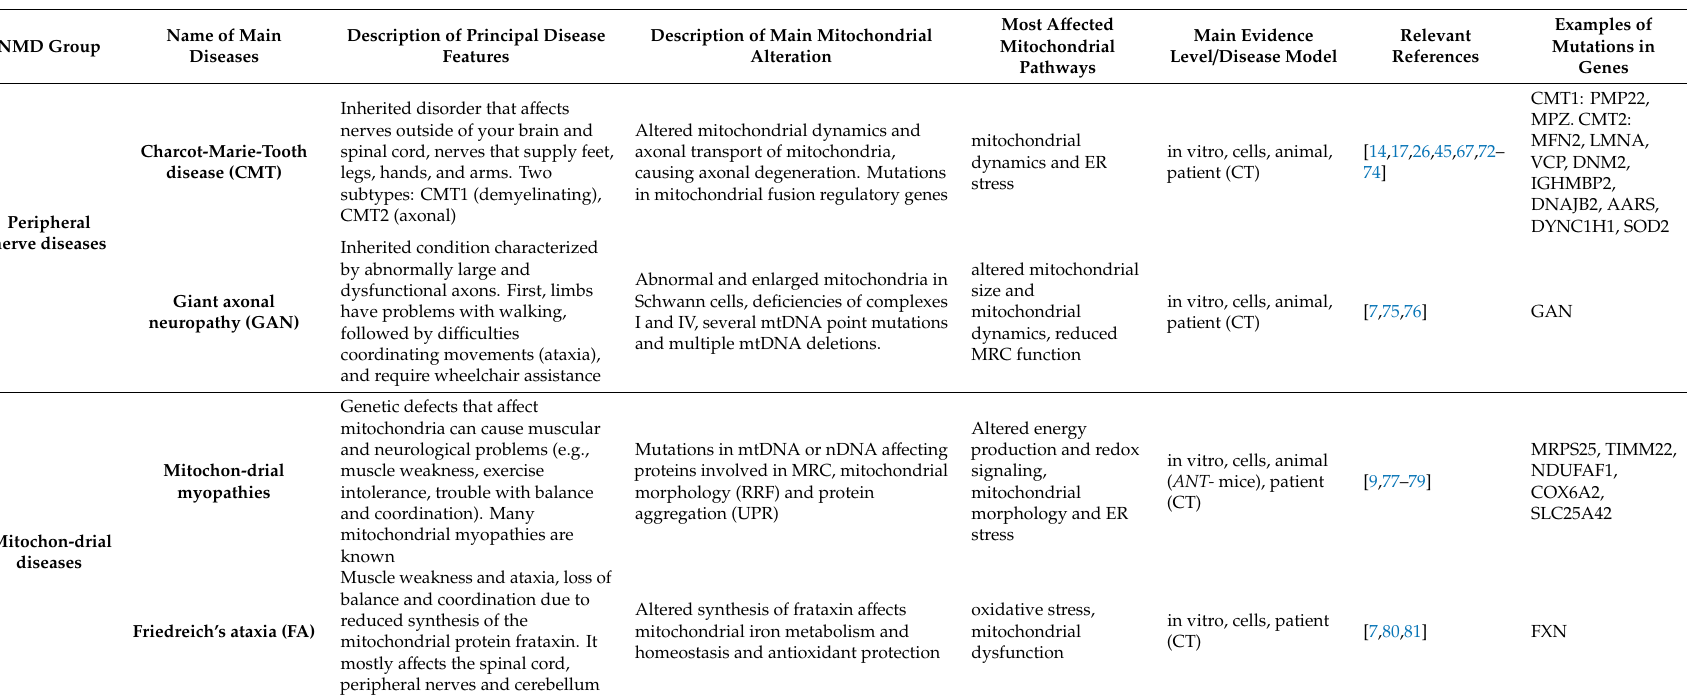
Table 4. Examples of studies reporting altered mitochondrial functions in peripheral nerve diseases and mitochondrial